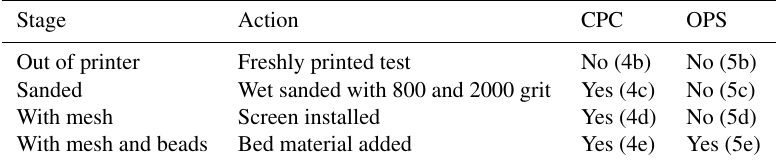
Table A1. PRIZE assembly stages, the action taken and the particle detection results at the CPC and OPS. Corresponding particle number concentration time-series measurements and size distributions are provided in Figs. 4 and 5,